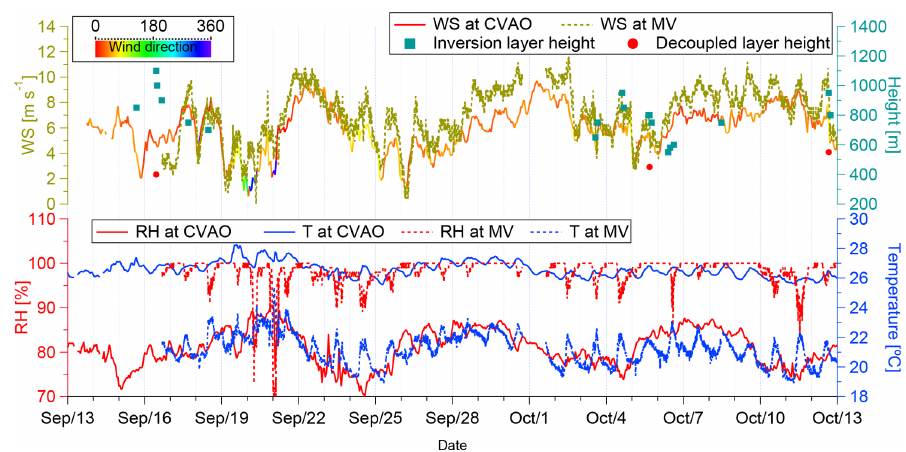
Figure 1. Time series of wind speed (WS), wind direction (CVAO only), RH and temperature. Parameters measured at CVAO are shown by solid lines and at MV in dashed lines. Time series of inversion layer height are shown by blue squares and decoupled layer height in red dots.